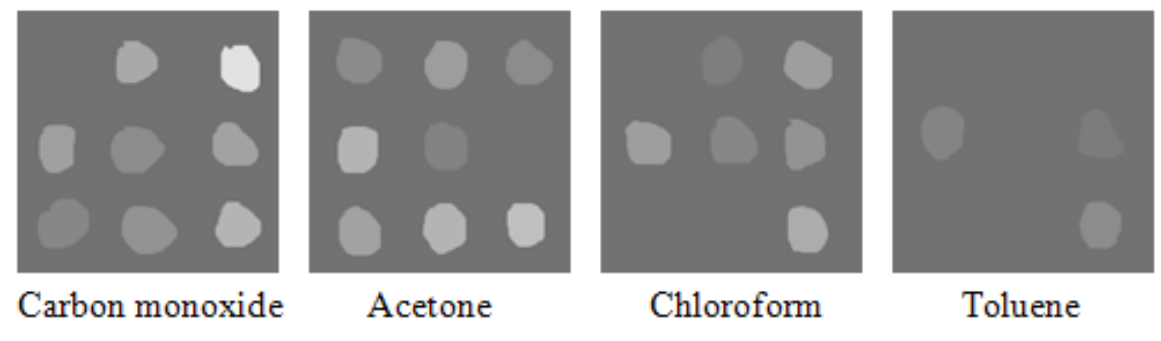
Figure 4. CTL sensor images of carbon monoxide, acetone, chloroform and toluene. Concentration of all compounds: 1000 ppm, working temperature: 240 °C, carrier gas flow rate: 200